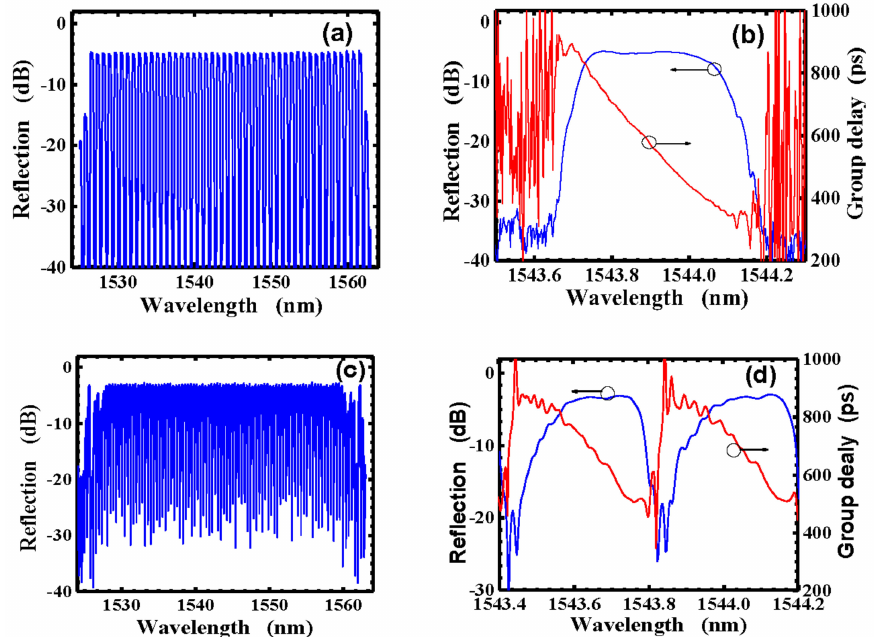
Figure 20. Measurement results for 45- and 81-channel FBGs. ( a ) Reflection spectrum for the 45- channel FBG and ( b ) reflection and group delay spectra in central channel of the 45-channel FBG. ( c ) Reflection spectrum for the 81-channel FBG and ( d ) reflection and group delay spectra in the central channel of the 81-channel FBG. Adapted with permission from ref. [112]. © The Optical